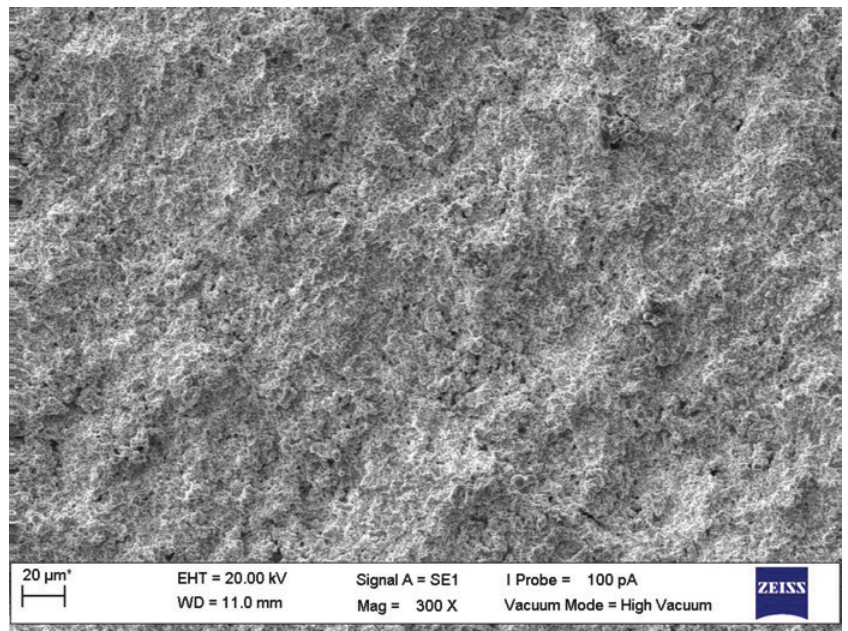
Fig. 3: Surface topography of WC-12Co